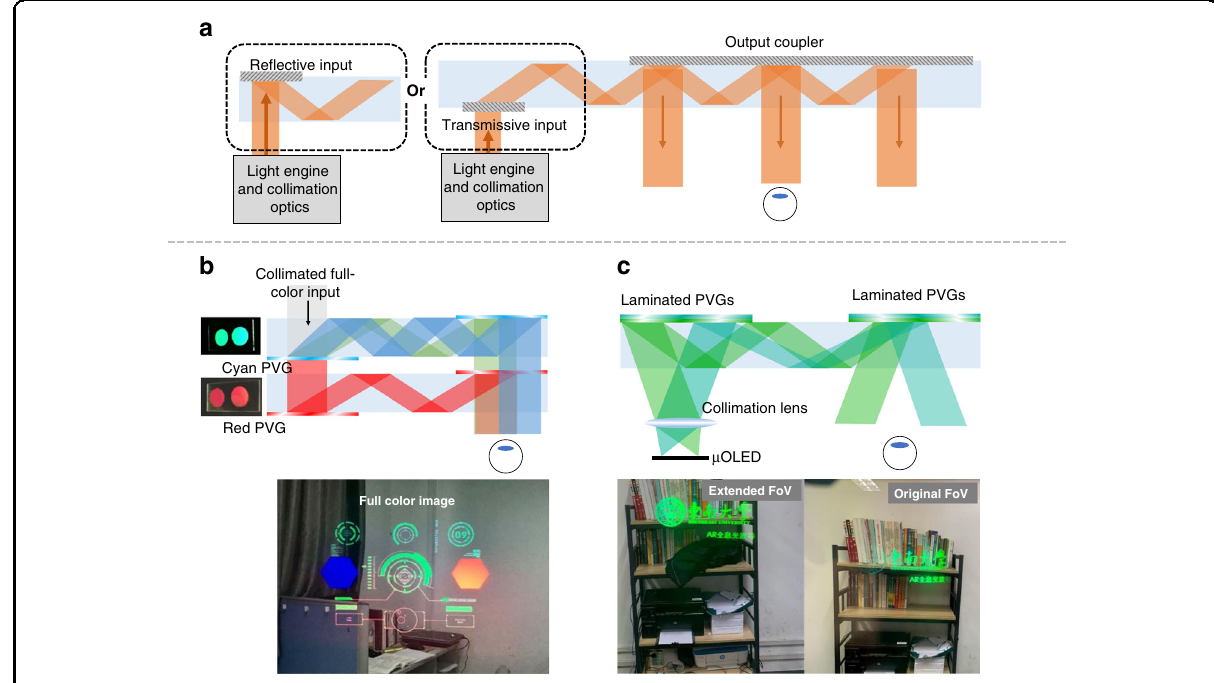
Fig. 14 Schemes of diffractive waveguide combiners and applications of PVG in waveguide AR. a Working principles of waveguide AR (transmissive input coupler and re fl ective input coupler). b System con fi guration of full-color waveguide AR display with experimental results. c Enlarged-FoV waveguide AR display with experimental results. Reproduced from b ref. 213 with permission from The Optical Society. Reprinted from